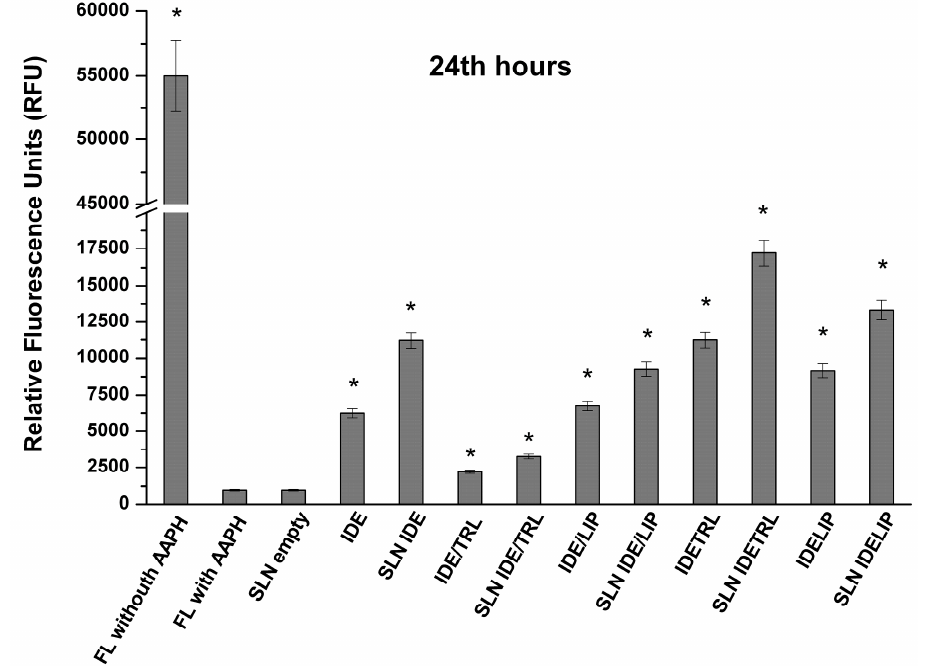
Figure 7. Antioxidant efficiency of IDE, IDETRL, IDELIP, and of the physical mixtures IDE/TRL and IDE/LIP, free or loaded into SLN, at the 24th hour. Data represent the mean of three independent experiments ± SD. * p < 0.05 with respect to the positive control.